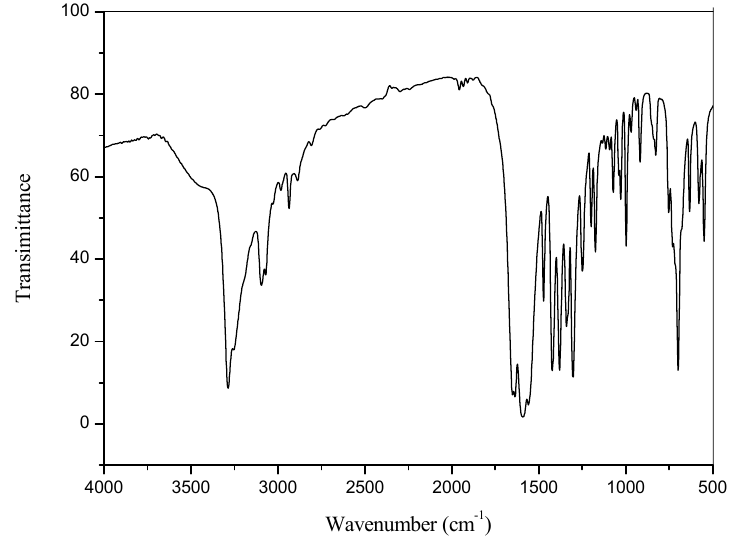
Figure 5. IR spectrum of complex 1 .